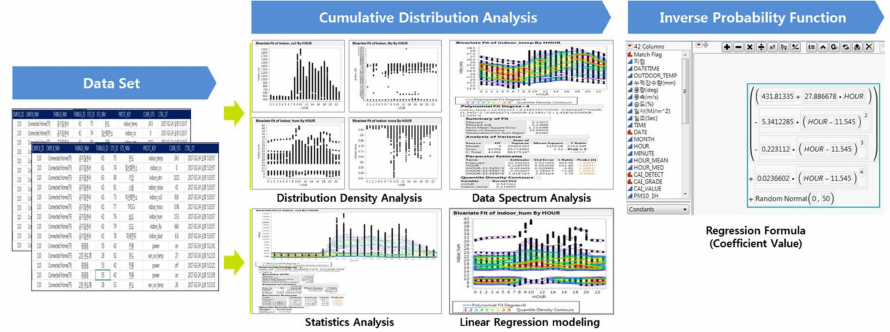
Figure 4. Cumulative distribution